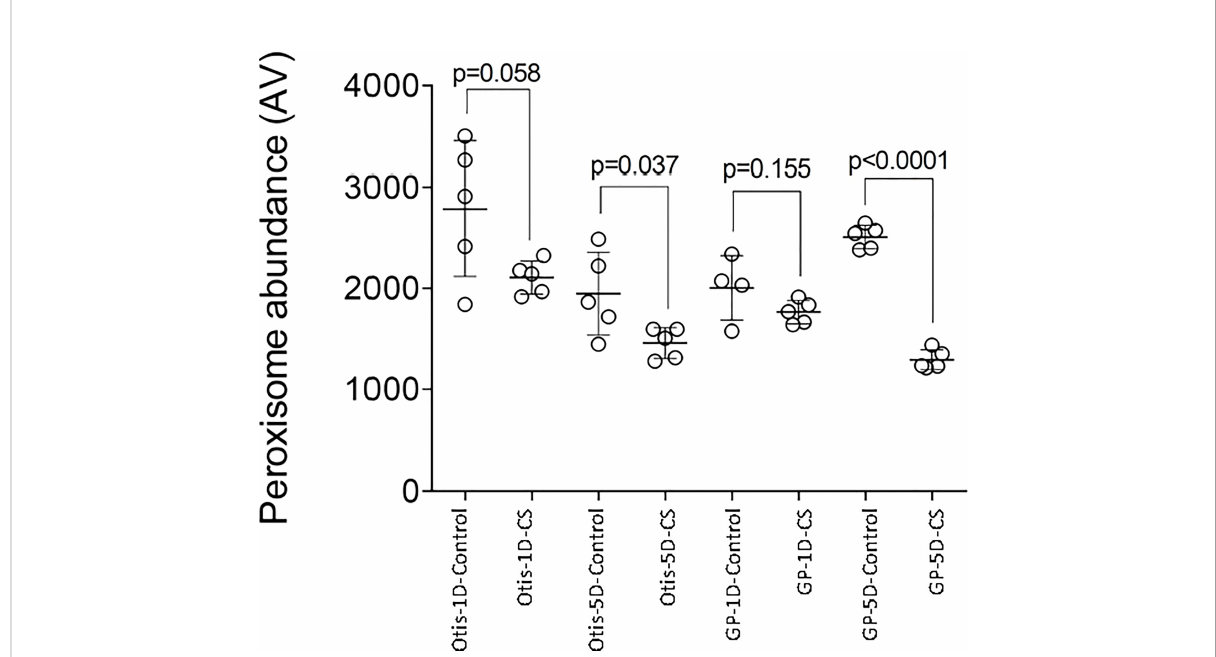
FIGURE 8 Impact of combined heat and drought stress (CS) on peroxisome abundance in Golden Promise (GP) and Otis. Values are from fi ve different samples. P-values represent the pair-wise comparison of control and stressed leaf samples for each time point and